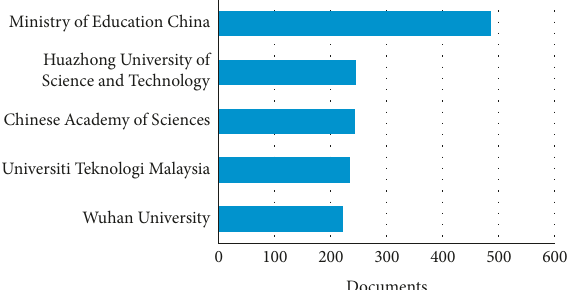
Figure 6: Research output of top institutions on PSOA research (2001–2021).